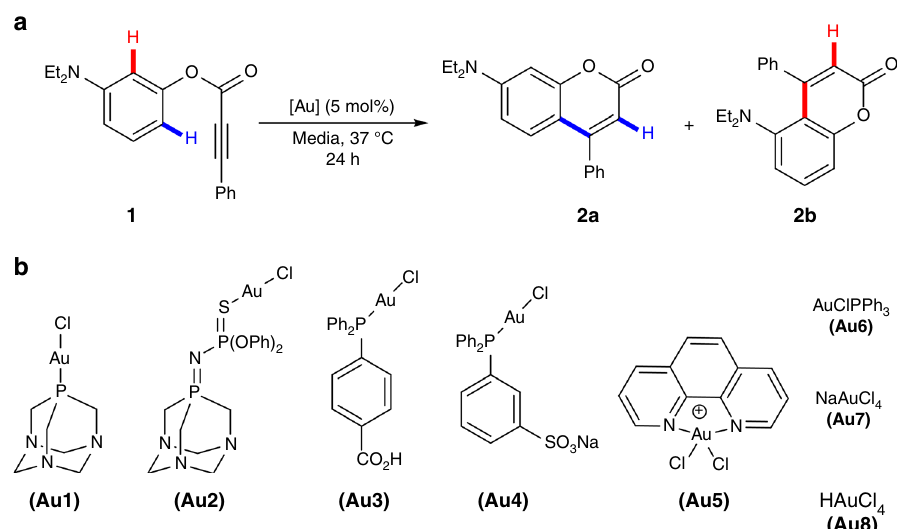
Fig. 2 Intramolecular gold-catalyzed hydroarylation of precursor 1 . a Schematic representation of the carbocyclization reaction. b Structure of the gold complexes Au1 – Au6 , and gold salts Au7 – Au8 used in this gold-catalyzed hydroarylation reactions in organic solvents, but not in aqueous media (Fig. 2a) 22 . The reaction was explored in water, at 37 °C, using several Au(I) and Au(III) complexes (Fig. 2b).